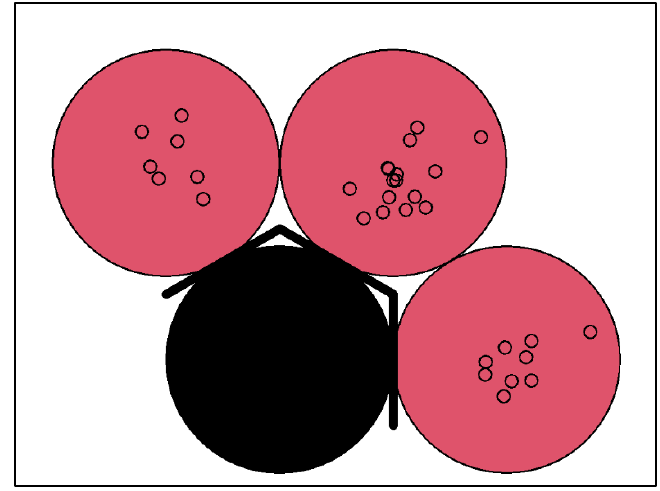
Figure 2. Clustering of SOM neurons using HC.